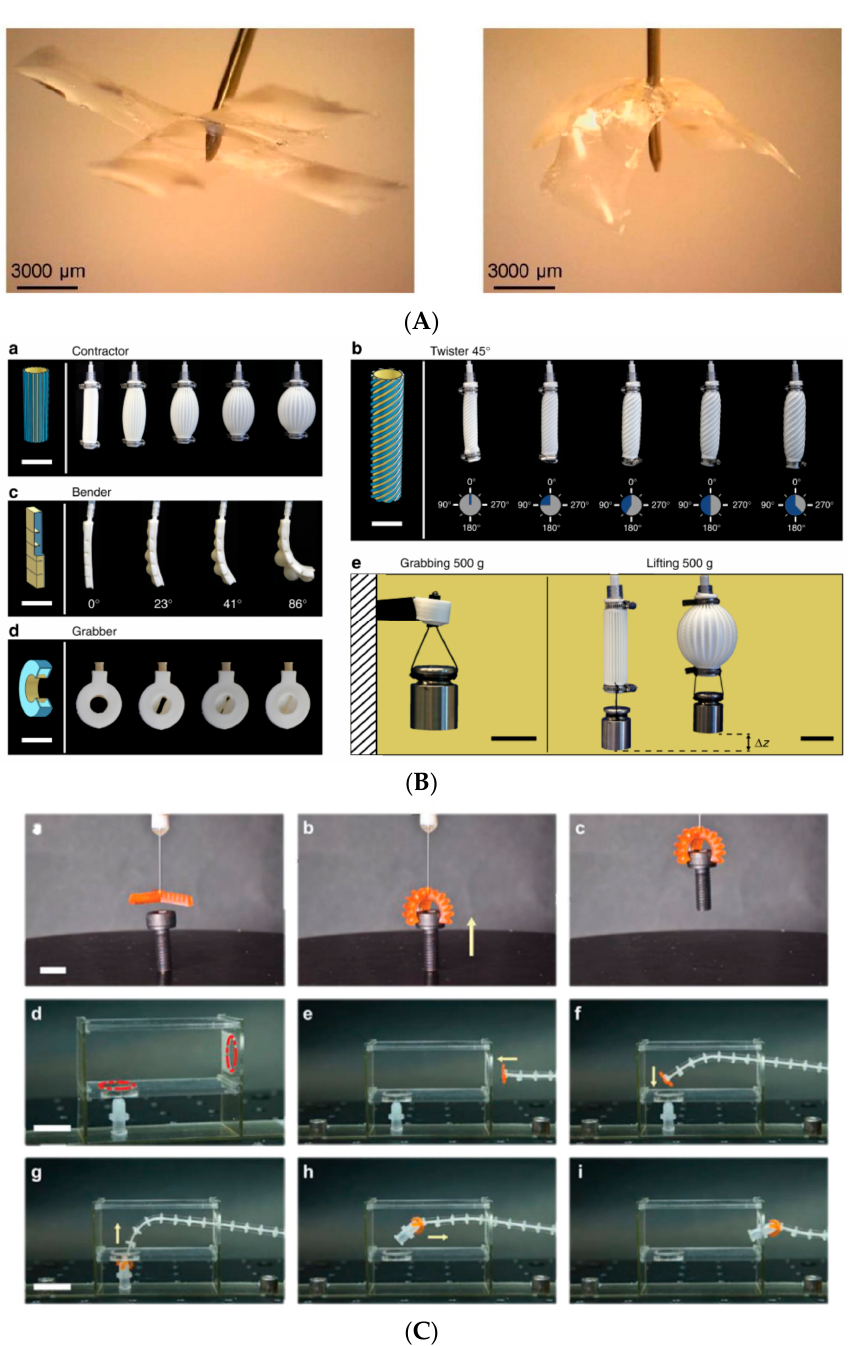
Figure 2. Examples of fabricated soft robotics: ( A ) Omnidirectional soft pneumatic actuator.